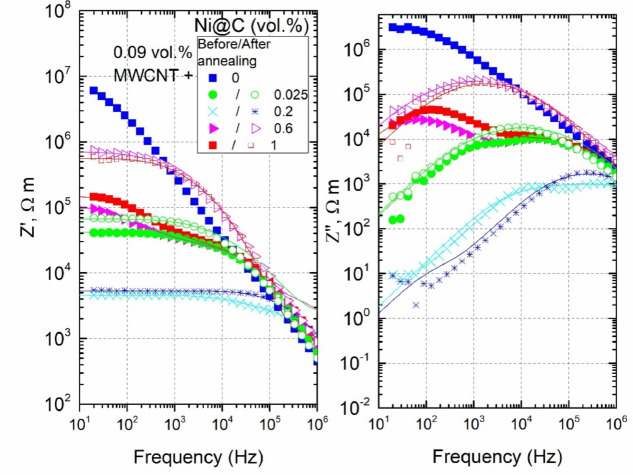
Figure 14. Frequency dependence of the complex impedance for hybrid Ni@C/MWCNTs/epoxy composites at room temperature before and after annealing at 500 K.